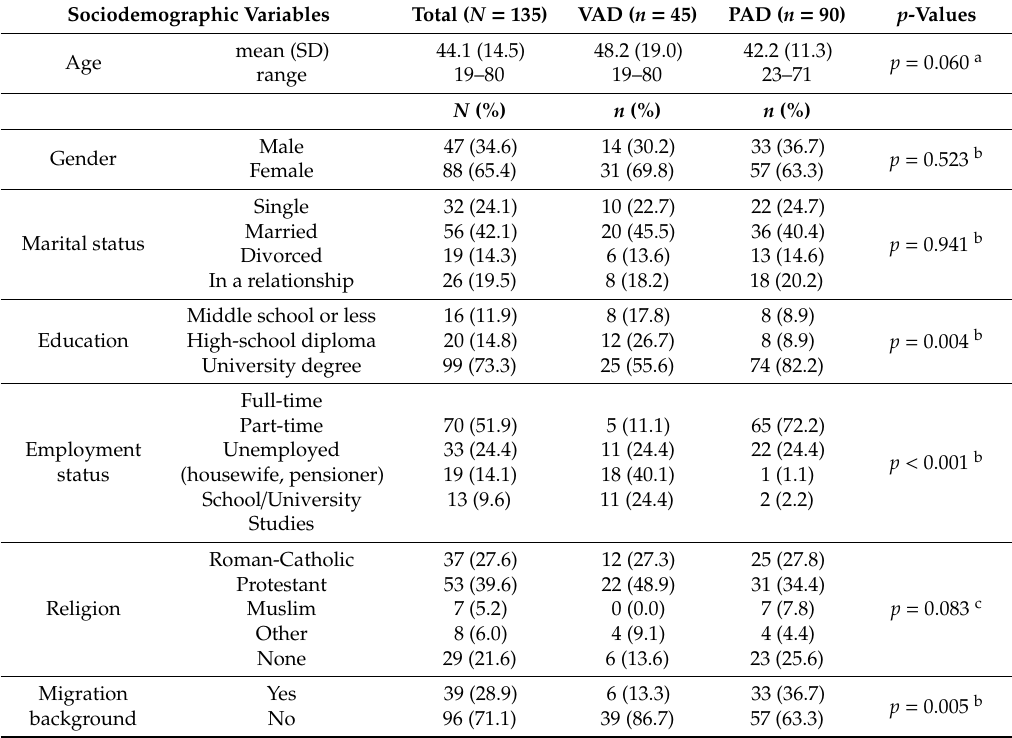
Table 1. Sociodemographic characteristics of the study